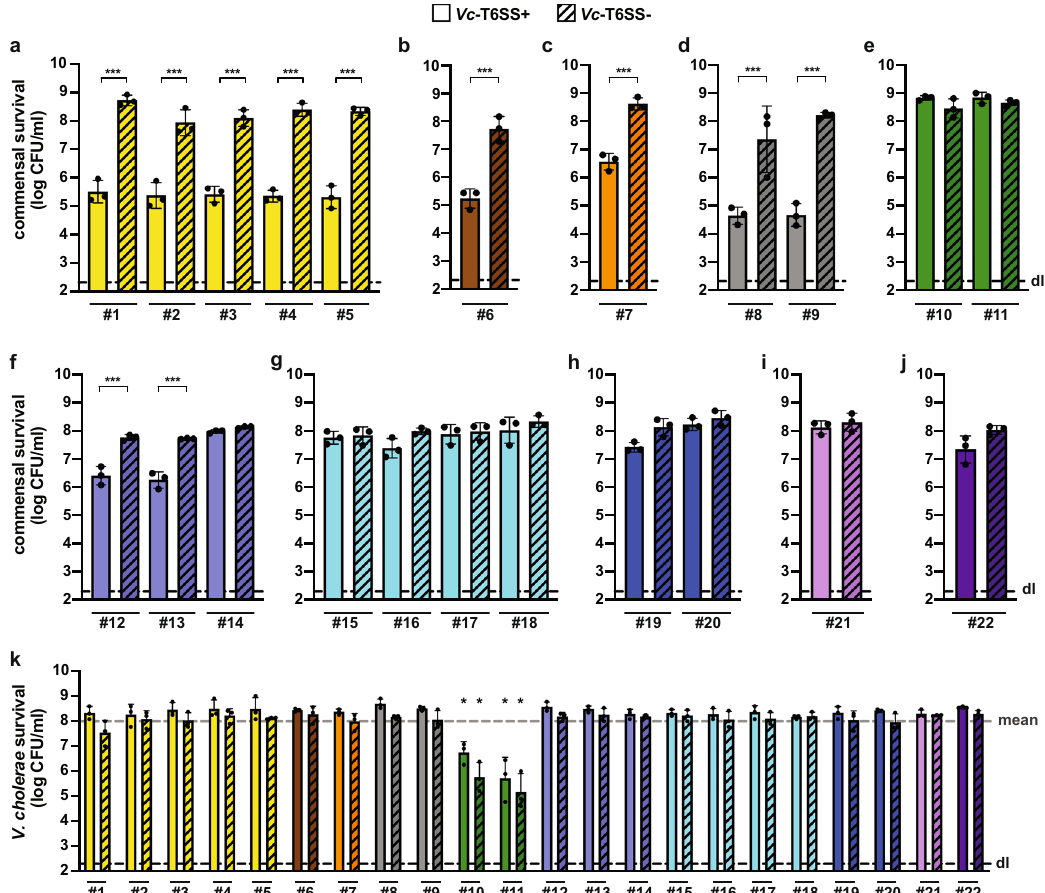
Fig. 1 A subset of human gut commensals is resistant to V. cholerae ’ s T6SS attacks. a – j Commensal Enterobacteriaceae show diverse sensitivity to T6SS assaults. Human commensals were tested for survival against toxigenic T6SS + (WT; plain bars) or T6SS- ( Δ vipA; stripped bars) V. cholerae . Isolates are grouped by taxa: a Escherichia coli; b Hafnia alvei; c Citrobacter freundii; d Kluyvera cryocrescens; e Enterobacter cloacae complex; f Klebsiella michiganensis; g Klebsiella oxytoca; h Klebsiella pneumoniae; i Klebsiella variicola; and j Klebsiella grimontii . The commensals ’ survival is indicated on the Y -axis. Signi fi cant differences were determined using a two-sided Student ’ s t -test corrected for multiple comparisons. Only signi fi cant differences are indicated. *** p < 0.001. k V. cholerae is killed by commensal Enterobacter isolates. The survival of T6SS + (WT; plain bars) or T6SS − ( Δ vipA ; stripped bars) V. cholerae when co- incubated with human commensals was scored. Color code and X -axis labels as in panels ( a – j ). * p < 0.05, indicating signi fi cant lower survival of V. cholerae (T6SS + & T6SS − ) when compared with the mean survival value of all the tested conditions (gray dashed line) as determined by two-sided Student ’ s t - tests. Values are derived from three independent experiments and the bars represent the mean (±SD, as de fi ned by the error bars). dl, detection limit, as indicated by the dashed line. Source data underlying all panels are provided in the Source data fi